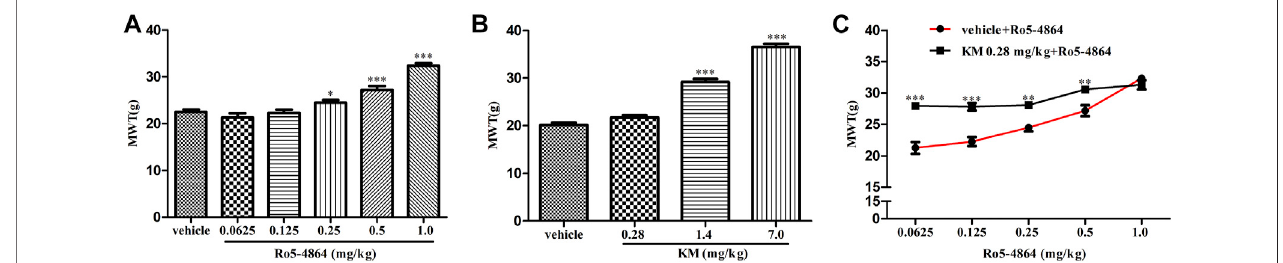
FIGURE 6 | Modulation of the in vivo ef fi cacy of Ro5-4864 by koumine in the rat model of CCI. (A,B) MWT was increased by acute Ro5-4864 (A) or koumine (B) administration in adose-dependent manner. (C) Dose responseeffectson the MWT of Ro5-4864 in the absence or presence of koumine (0.28 mg/kg). Koumine (0.28, 1.4 and 7.0 mg/kg) or vehicle was injected s. c. 9 days after CCI surgery, the MWT was determined 60 min after koumine injection. Ro5-4864 (0.0625, 0.125, 0.25, 0.5 and 1.0 mg/kg) or vehicle was injected i. p. 9 days after CCI surgery, the MWT was determined 50 min after Ro5-4864 injection. To determine whether koumine potentiated the analgesic effects of Ro5-4864, koumine (0.28 mg/kg, s. c.) or vehicle was injected 10 min before Ro5-4864 (0.0625 – 1.0 mg/kg, i. p.) injection on day 9 after CCI surgery, and the MWT was determined 50 min after the last injection. Abbreviations; KM: koumine, MWT: mechanical withdrawal threshold. Data are represented as the mean ± SEM, * p < 0.05, ** p < 0.01, *** p < 0.001 vs. the corresponding vehicle group. Statistical analysis in (A,B) were performed using one-way ANOVA followed by the LSD post hoc test and in (C) was performed using the independent samples t -test. Each group consisted of 6 – 10 rats.